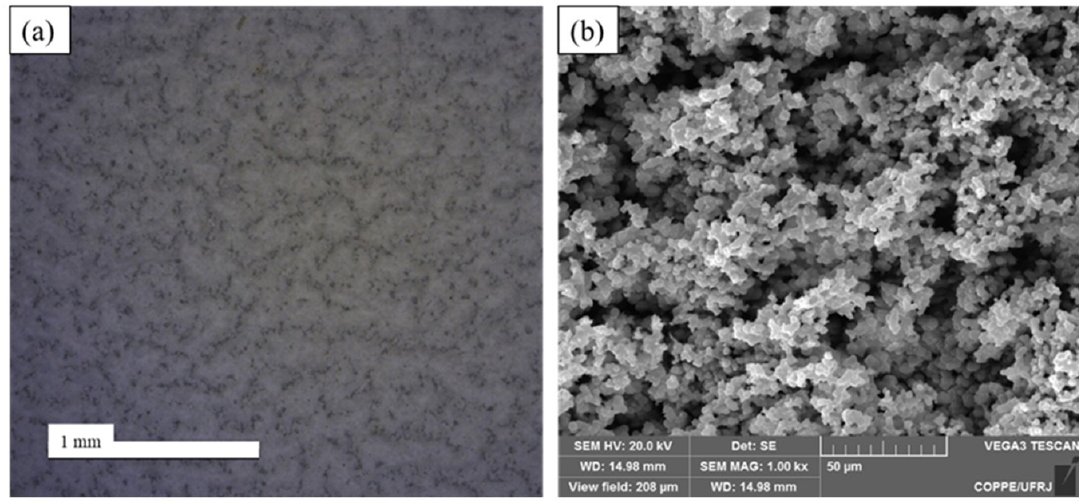
Figure 3. (a) optical microscopy and (b) SEM images of coating